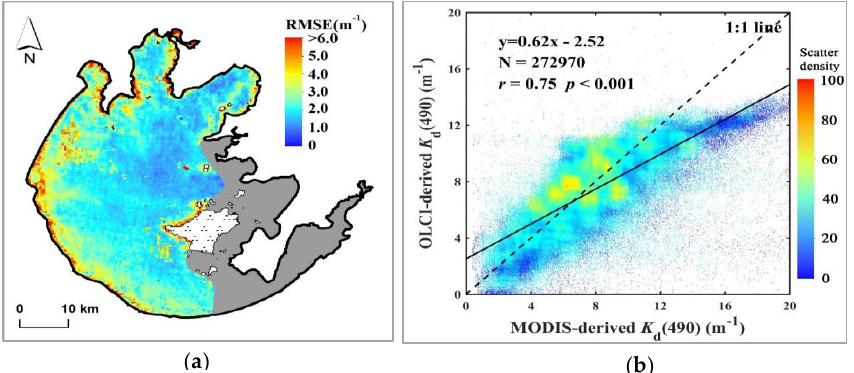
Figure 12. Distribution of the RMSE ( a ) and pixel-by-pixel scatter plot ( b ) between all of the K d (490) products from the OLCI and MODIS. A total of 18 OLCI-MODIS image matchups were used, and six matchups with large uncertainties in the MODIS atmospheric correction were excluded. Note that bad pixels were removed.